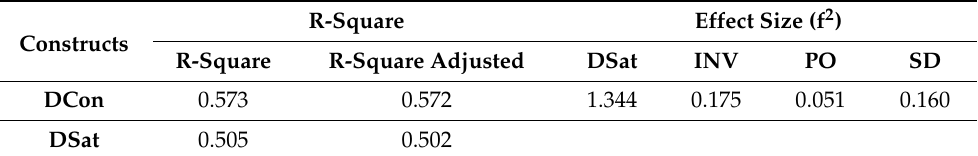
Table 5. Explanatory power ( R 2 ) and effect size of the model.